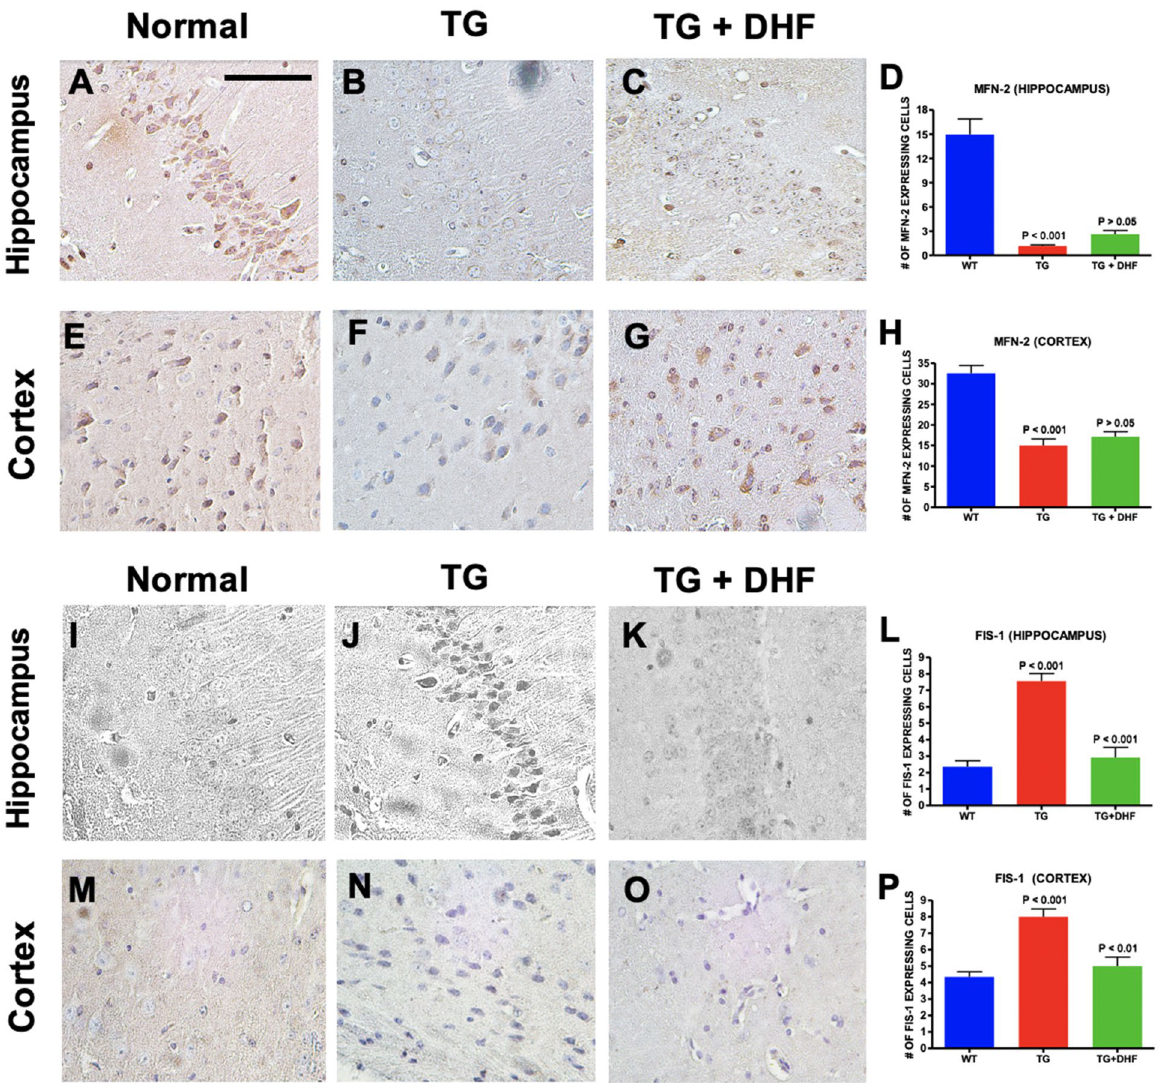
Figure 7. DHF treatment improved mitochondrial fission, but not fusion. Legend: MFN-2 and FIS-1 expression in the hippocampus and cortex of Wild Type (WT), Tg26, and DHF treated Tg26 mice ( A - P ). Immunohistochemical stained sections show MFN-2 and FIS-1 expressing cells in the hippocampal and cortex regions of the mice brains. 4 WT mice, 5 Tg26 mice, and 4 TG + DHF mice were used for MFN-2. 4 WT mice, 3 Tg26 mice, and 3 Tg + DHF mice were used for FIS-1. A, B, C, E, F, G, I, J, K, M, N, and O are 400 × magnification pictures of the hippocampus and cortex regions of the mice. ( D ) Quantification of MFN-2 expressing cells in the hippocampus: p < 0.001, WT versus Tg; p > 0.05, Tg versus Tg + DHF. ( H ) Quantification of MFN-2 expressing cells in cortex: p < 0.001, WT versus Tg; p > 0.05, Tg versus Tg + DHF. ( L ) Quantification of FIS-1 expressing cells in the hippocampus: p < 0.001, WT versus Tg; p < 0.001, Tg versus Tg + DHF. ( P ) Quantification of FIS-1 expressing cells in cortex: p < 0.001, WT versus Tg; p < 0.01, Tg versus Tg + DHF. The total numbers of hippocampal fields analyzed (WT, Tg26, TG + DHF) for each antibody were MFN-2 (103, 93, 63), FIS-1 (40, 30, 33). The total numbers of cortex fields analyzed (WT, Tg26, TG + DHF) for each antibody were MFN-2 (17, 22, 18), FIS-1 (20, 20, 15). One Way ANOVA with Bonferroni’s Multiple Comparison post- test. scale bar, 100 by reducing CXCR4 and CCR5 expression in the hippocampus and brain cortex (Fig. 2), perhaps by increasing BDNF-TrkB signaling mechanisms, in the Tg26 model. Downregulating NF-kB may also have attenuated the expression of CXCR4 and CCR5, as these chemokine receptors play a role during neuroinflammation in HAND and previous studies suggest that NFkB mediates their expression 62–64 . Given that TrkB activation modulates CXCR4 and CCR5 expression, our findings suggest that this effect may be mediated by NF-kB 54,65 . Viral proteins such as gp120, Tat, and Vpr are indirectly neurotoxic by binding to CXCR4 and CCR5 and activating macrophages, microglia, and astrocytes 66 . This indirect neurotoxicity fosters an environment of chronic inflammation that is characteristic of HAND 66 . HAND is characterized by glial activation, cytokine/ chemokine dysregulation, and neuronal damage and loss 9,67 . Even in the cART era, microgliosis, microglial